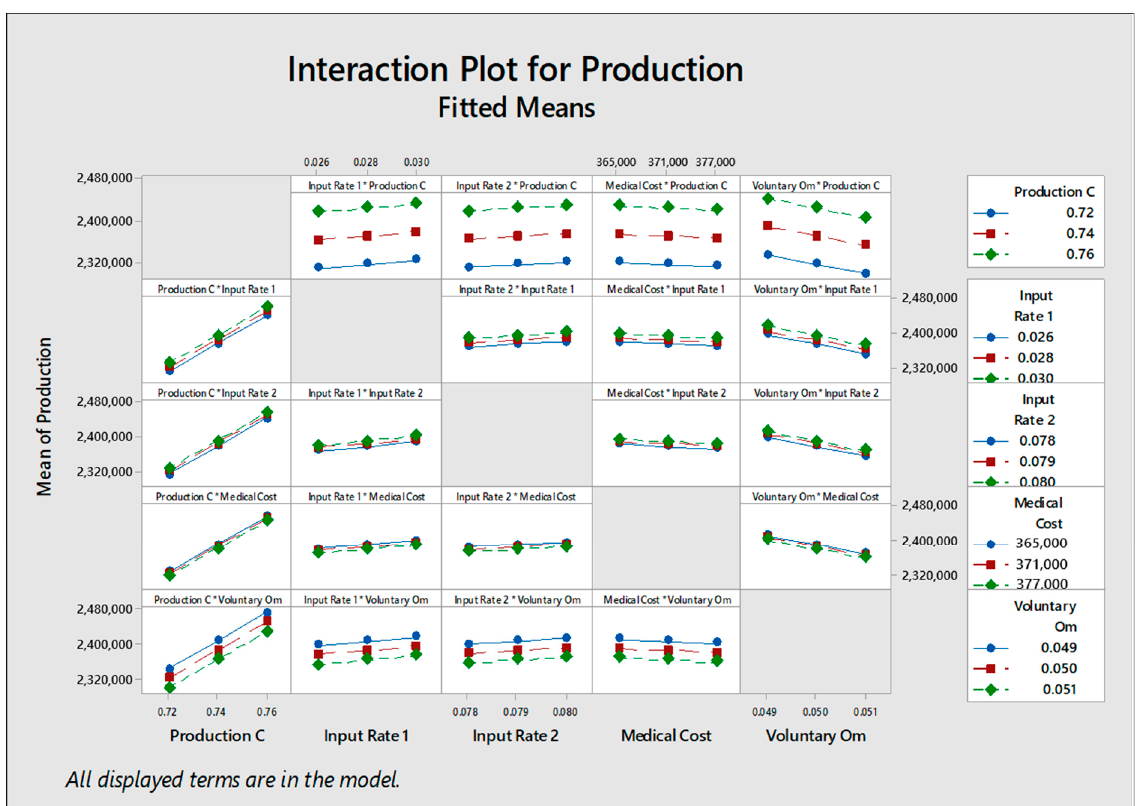
Figure 8. Interaction diagram of the effect of every identified important variable and their effect on the production.